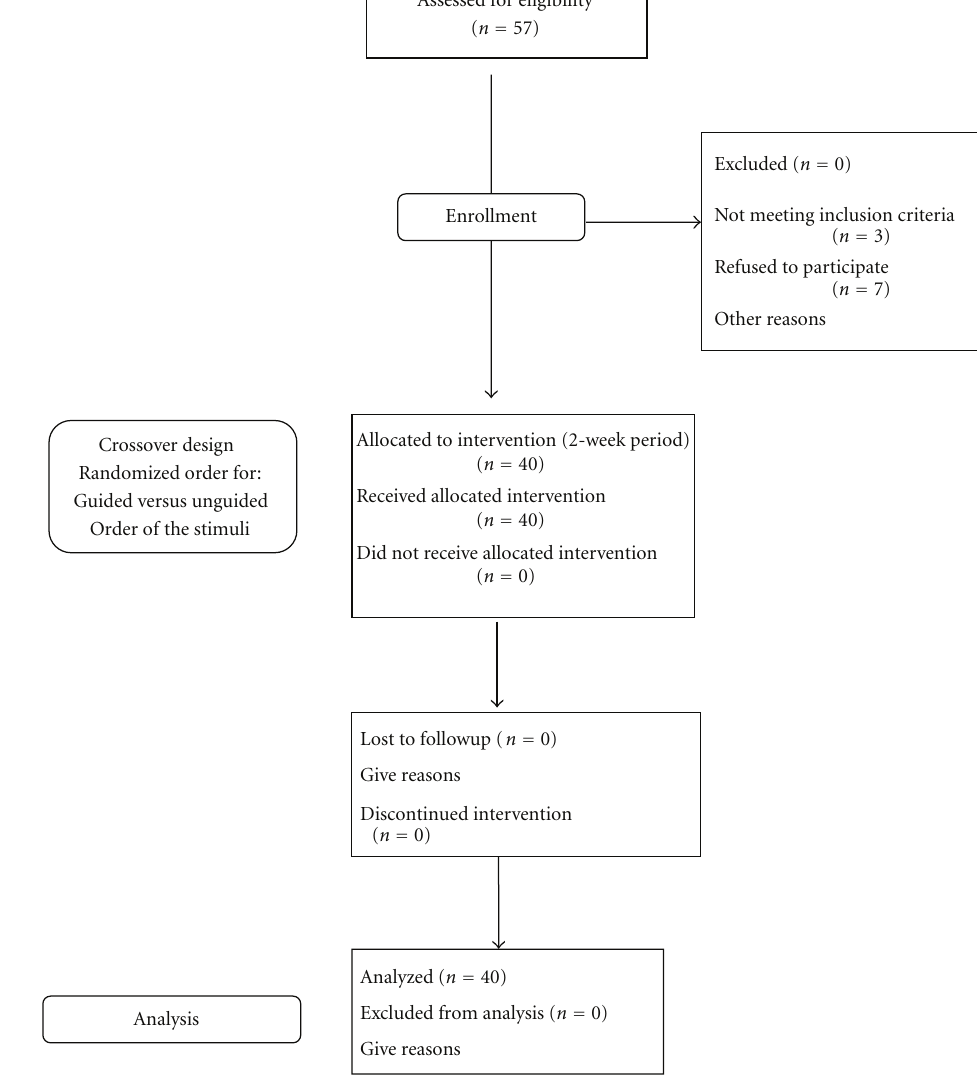
Figure 1: Participants